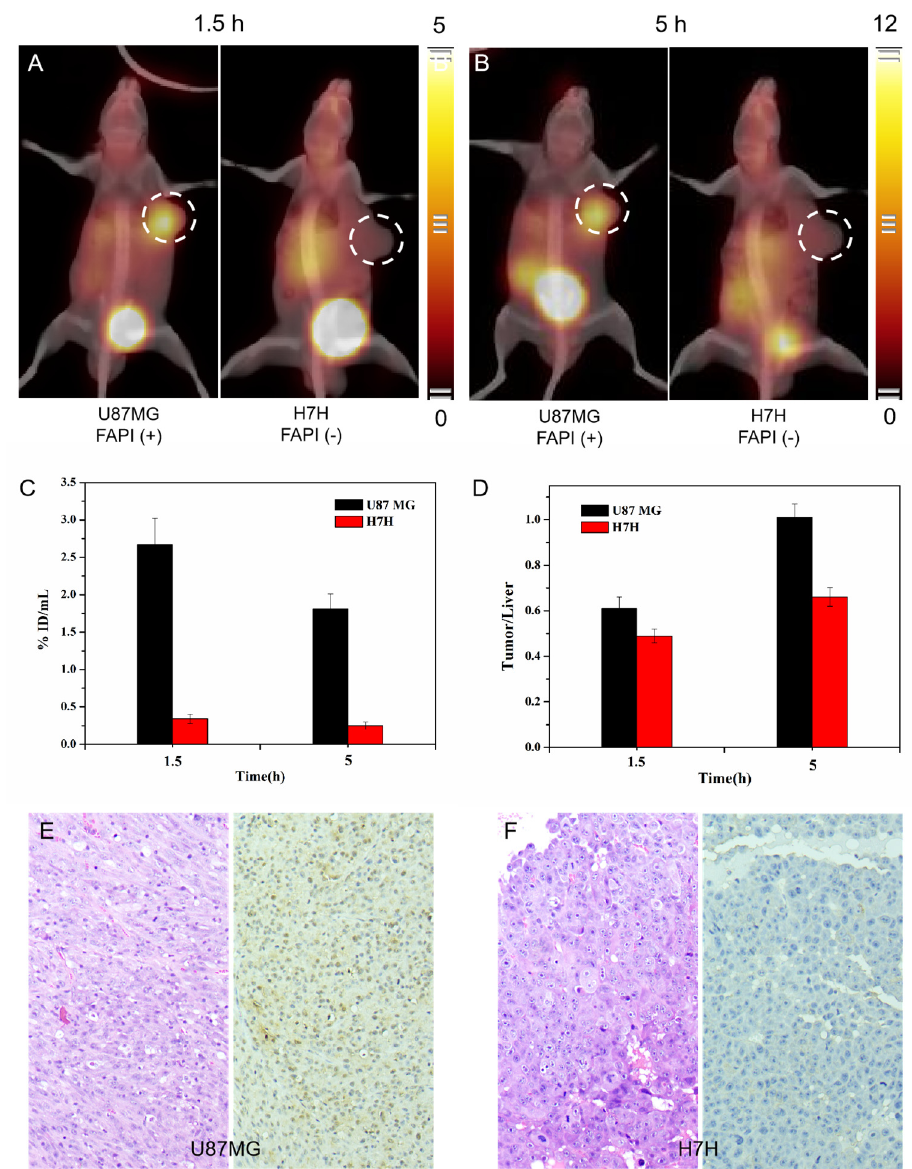
Figure 3. 99m Tc-HYNIC-FAPI-04 SPECT images of mice models with FAP-positive or FAP-negative xenografts at 1.5 h P.I. ( A ) and 5 h P.I. ( B ). The radioactive counts of FAP-positive or FAP-negative xenografts ( C ) and the ratios of xenografts to liver ( D ). The corresponding HE staining and quanti- tative analysis with immunohistochemical proves of FAP-positive ( E ) or FAP-negative tumors ( F ).